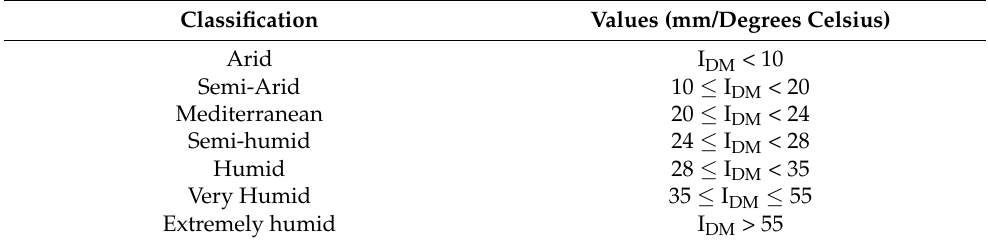
Table 2. Type of climate according to the De Martonne aridity index (I DM , adapted after Baltas [24]).